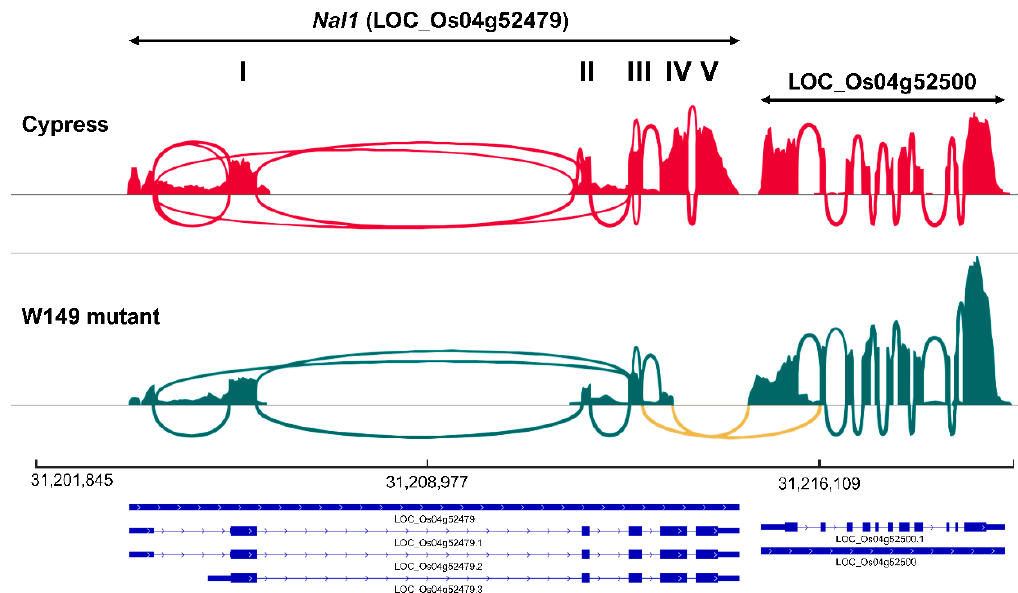
Figure 7. Sashimi plots showing spliced junction (marked yellow) between Nal1 (LOC_Os04g52479) and LOC_Os04g52500 in W149 compared to Cypress. The height of the bars represents read coverage. The splice junctions are displayed as loops. The exon numbers I through V of Nal1 are indicated on the top of the panel. The MSU v7.0 gene model with three known transcript variations of Nal1 is displayed below. The plots were visualized using IGV (v.2.8.4, Broad Institute, Cambridge, Massachusetts, USA).